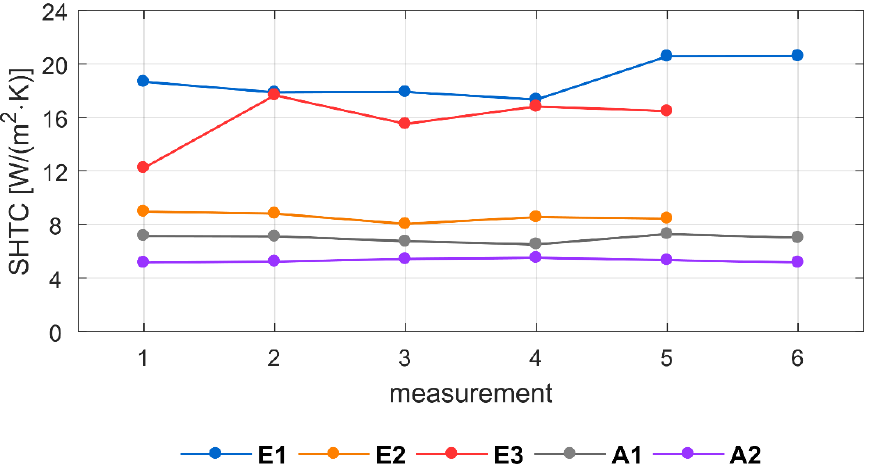
Figure A6. Surface heat transfer coefficient (SHTC; h si ) estimated from preliminary measurements at the roof window and the balcony door window (see Figure A1). Table A2. Surface heat transfer coefficient — overview of measured values.